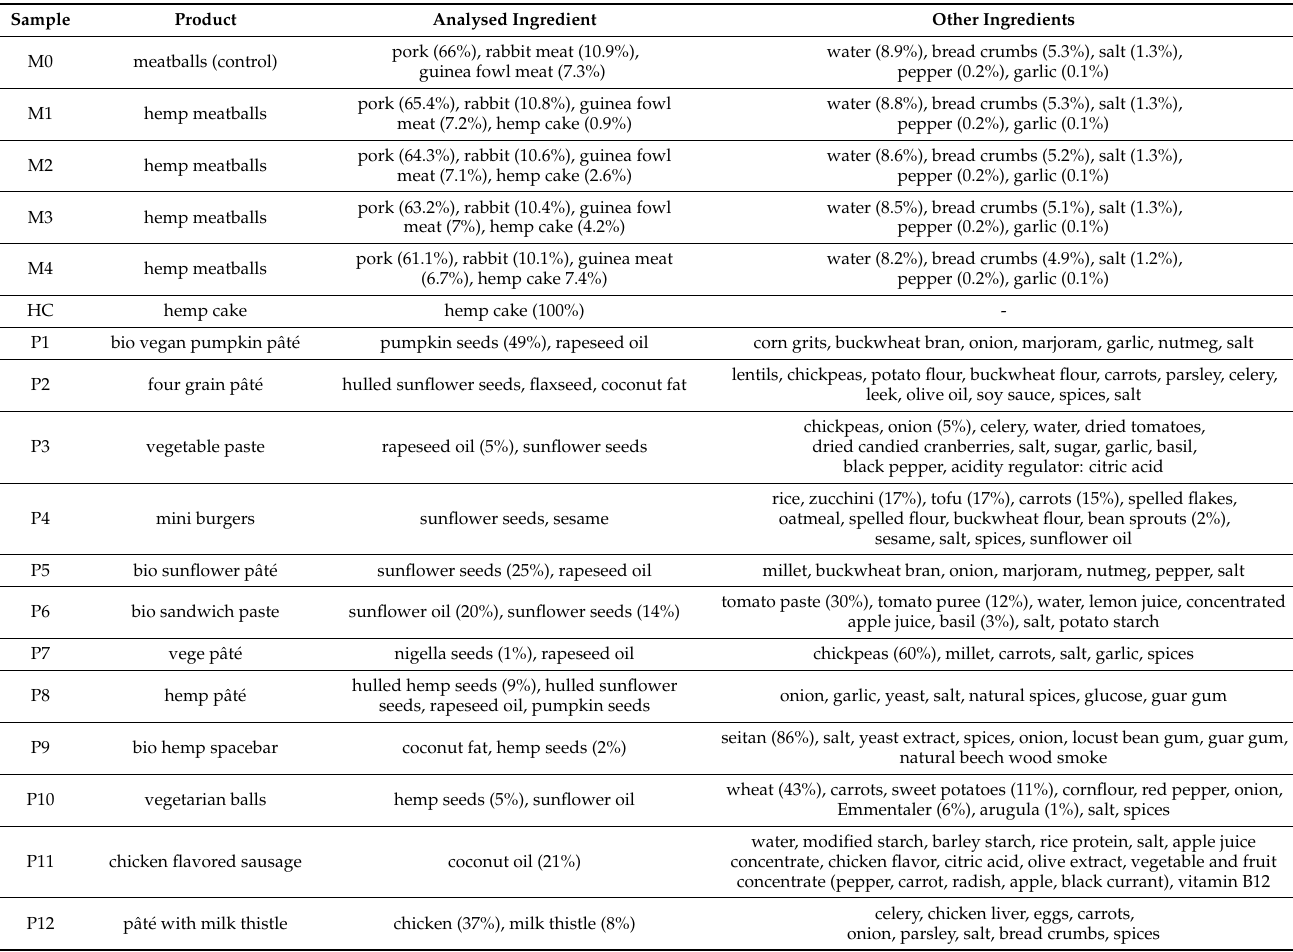
Table 1. Meat and oilseed species composition of the analysed food